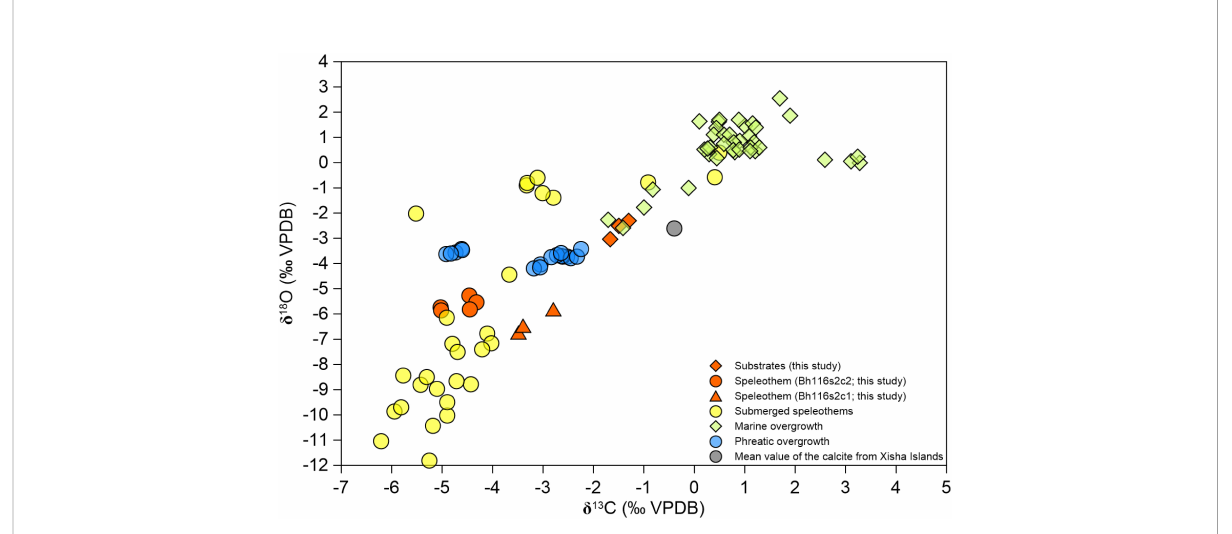
FIGURE 7 Stable carbon and oxygen isotopic composition of subsamples from coastal caves. Data of submerged speleothems, marine overgrowth, and phreatic overgrowth are from coastal caves of Belize, Eastern Adriatic Coast, and Mallorca (Suric ́ et al., 2005; Tuccimei et al., 2010; Gischler et al., 2017). The mean values of the calcite from Xisha Islands are adopted from Bi et al.